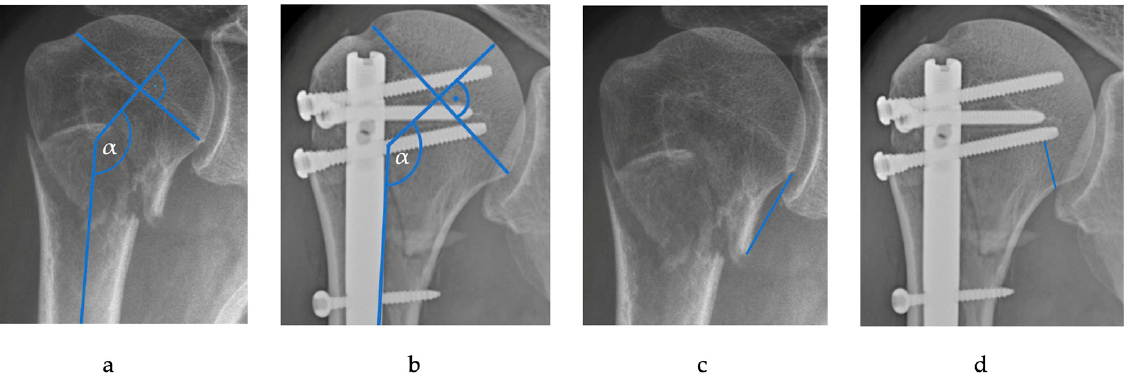
Figure 2. Illustration of measurement of the neck-shaft angle = α ( a ); preoperative and ( b ); postoperative), the metaphyseal head extension ( c ), and measurement of the distance of the distal head screw to the calcar ( d ).